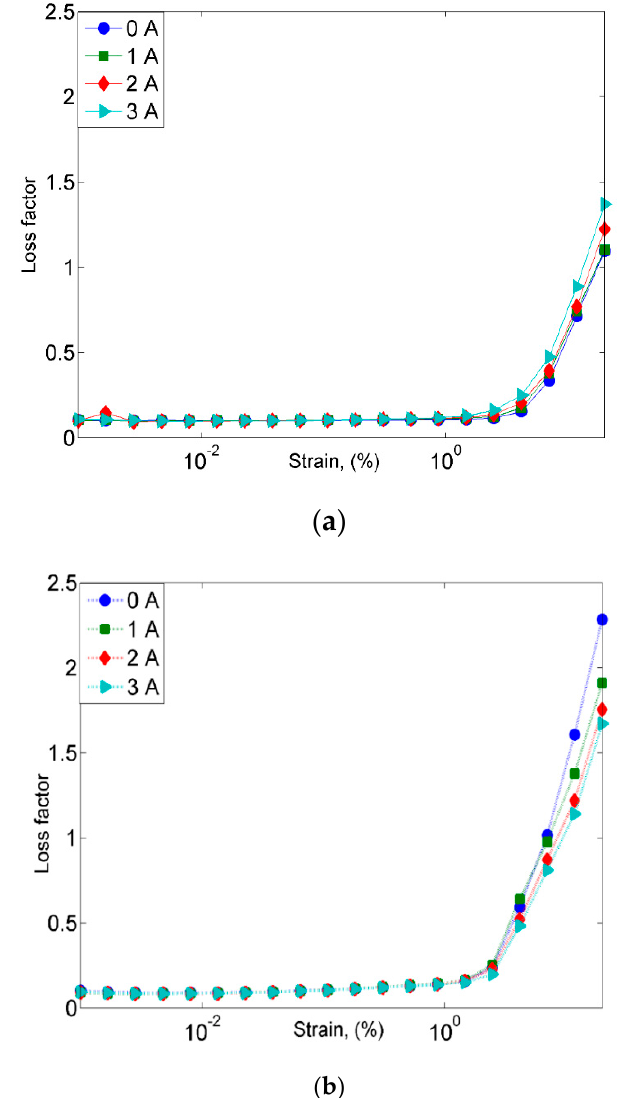
Figure 12. Loss factor vs. strain for ( a ) MRE with non-corroded CIPs and ( b ) MRE with corroded CIPs.